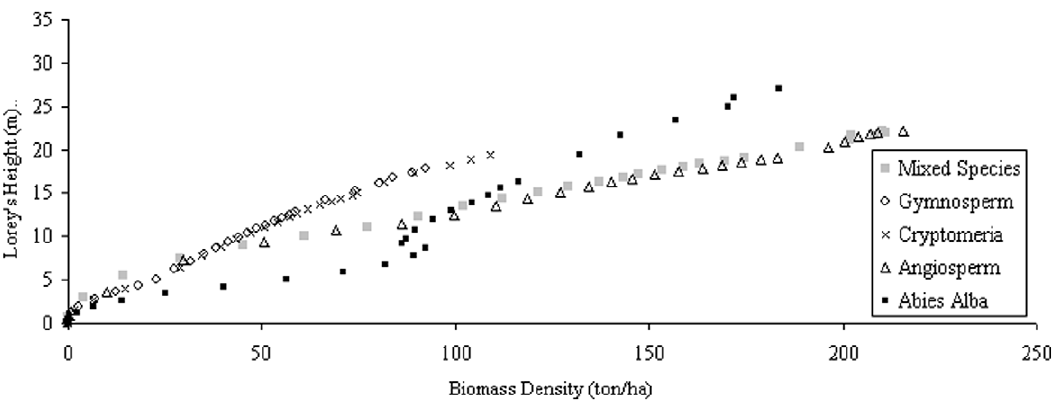
Figure 7. H Lorey against stem biomass density for planting densities of 10,000 ha 2 1 .